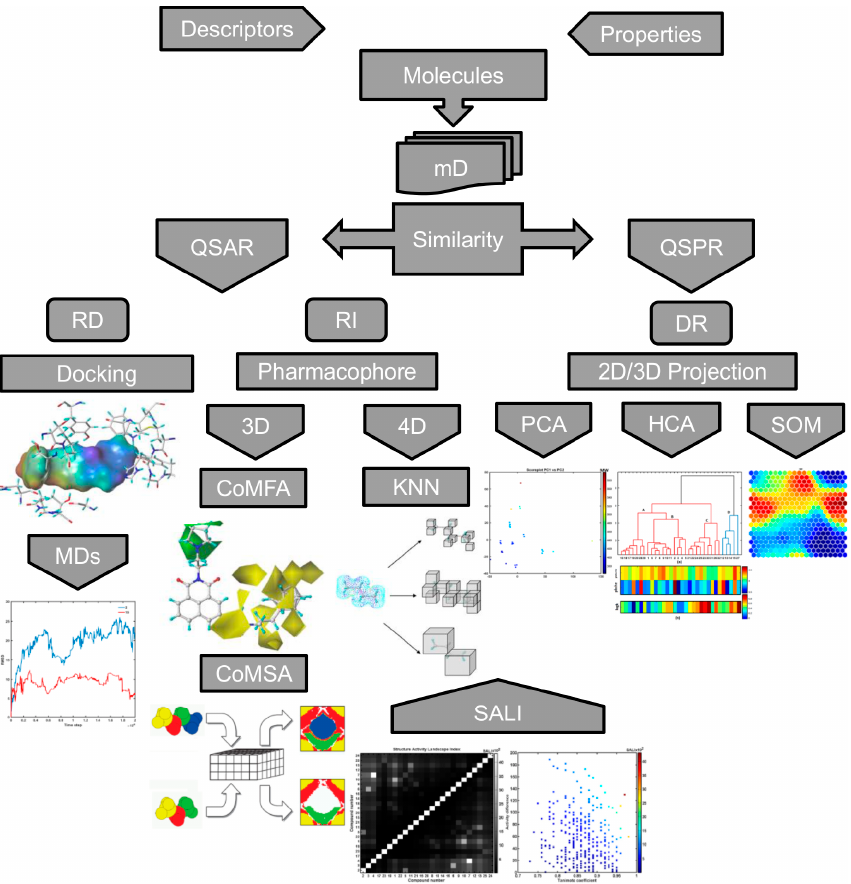
Figure 1. Workflow of descriptor-based data in similarity-related property modeling (details in text).